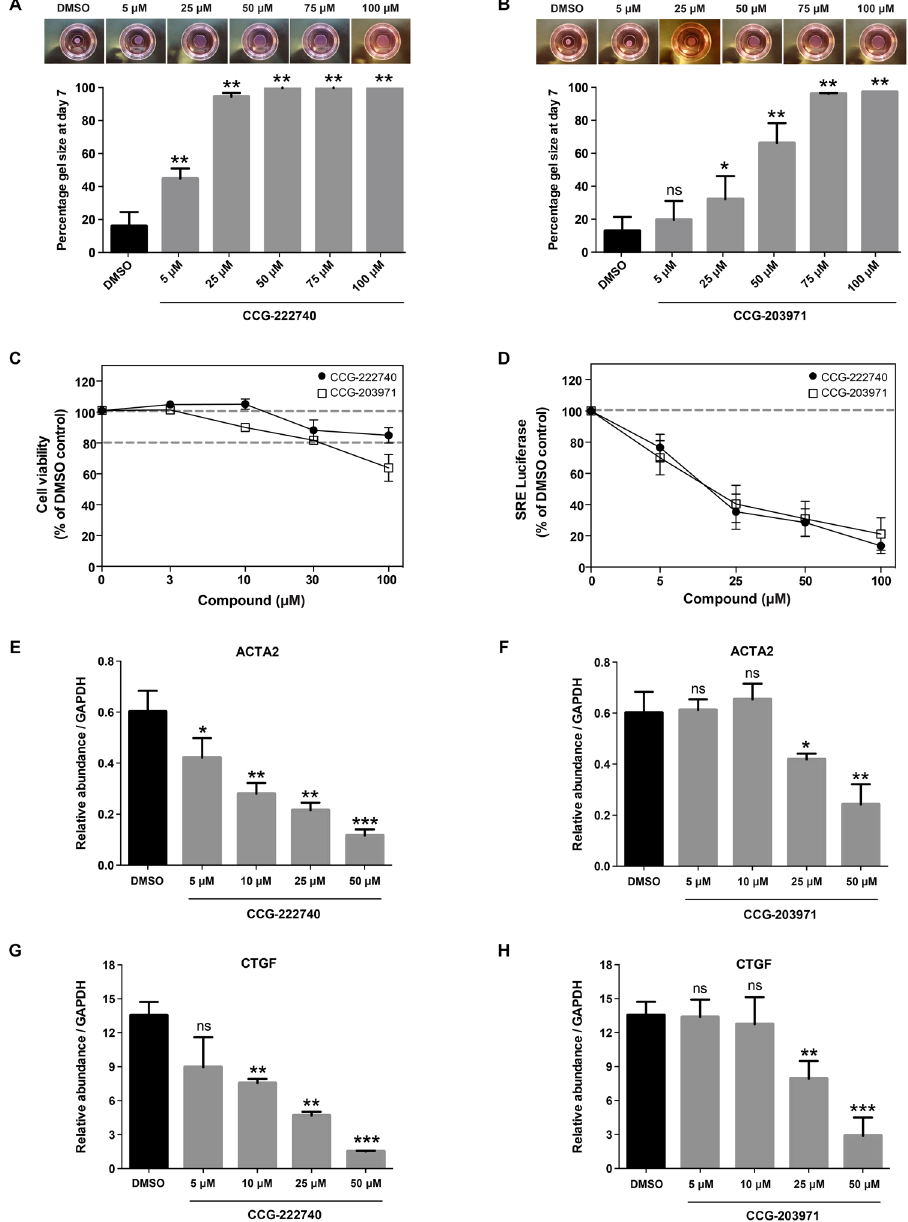
Figure 1. CCG-222740 is an effective MRTF/SRF pathway inhibitor. ( A , B ) Human conjunctival fibroblasts were seeded in collagen type I matrix and cultured for 7 days with or without CCG-222740 and CCG-203971 at the indicated concentrations. Each experiment used triplicate gels per condition, and the experiment was repeated three times; ( C ) Effect of CCG-222740 and CCG-203971 in cell proliferation, assessed using CellTiter 96 Aqueous one solution assay. Results are mean ± SEM for triplicate experiments; ( D ) Human conjunctival fibroblasts were transfected with the SRF reporter gene 3DA.Luc, serum-starved, and treated with different concentrations of CCG-222740 or CCG-203971 or 0.1% DMSO control for 24 hours. Results represent mean ± SEM for triplicate experiments; ( E , F , G , H ) Human conjunctival fibroblasts were treated with different concentrations of CCG-222740 or CCG-203971 or 0.1% DMSO control in 10% FCS + DMEM for 24 hours, and MRTF/SRF target gene expression assessed by qRT-PCR. Results represent mean ± SEM for triplicate experiments. * P < 0.05; ** P < 0.01; *** P <